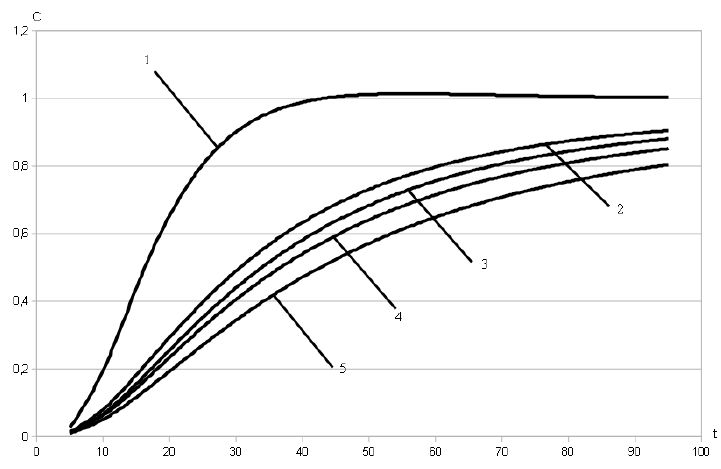
Figure 4. Dynamic of concentration field at the point ϕ = 2.44, ψ = 0.5.